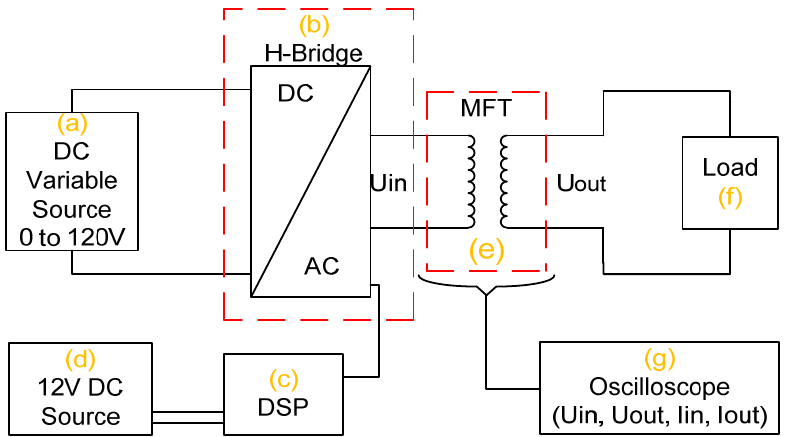
Load, and ( g ) Oscilloscope.